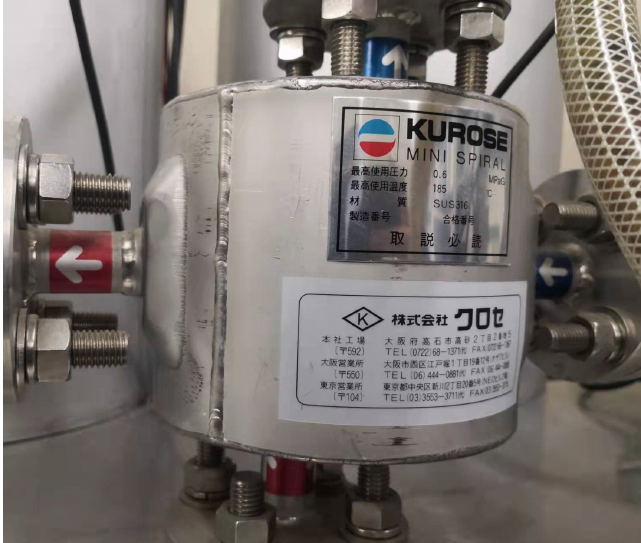
Figure 1. A spiral-plate heat exchanger plant.